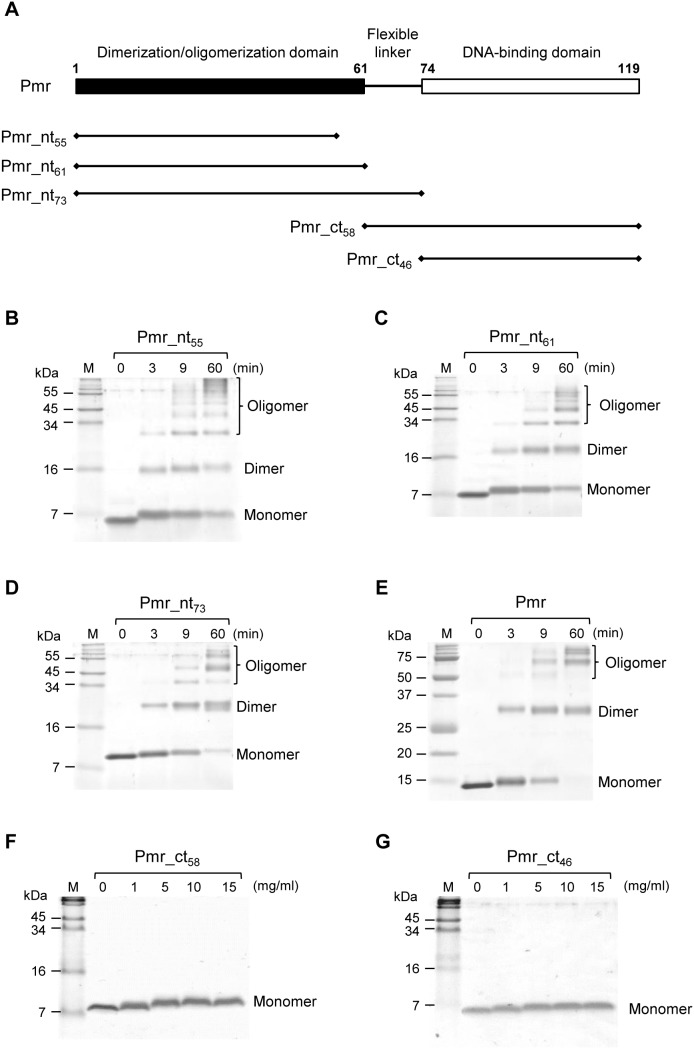
Effect of truncation on the homo-oligomerization capacity of Pmr.(A) Schematic representation of Pmr derivatives. Putative domain organization and a set of C-terminally or N-terminally truncated forms of Pmr, characterized in this study, are shown. Numbers indicate positions of amino acids. (B)–(G) Tricine-SDS-PAGE profiles of Pmr_nt55 (B), Pmr_nt61 (C), Pmr_nt73 (D), Pmr (E), Pmr_ct58 (F), and Pmr_ct46 (G) after chemical cross-linking. The analyses were performed using DMS as a cross-linker. Numbers indicate incubation durations (min) with DMS (B–E) or concentrations (mg/ml) of DMS (F, G). “M” indicates the protein marker. The bands corresponding to oligomers, dimers, and monomers are indicated.